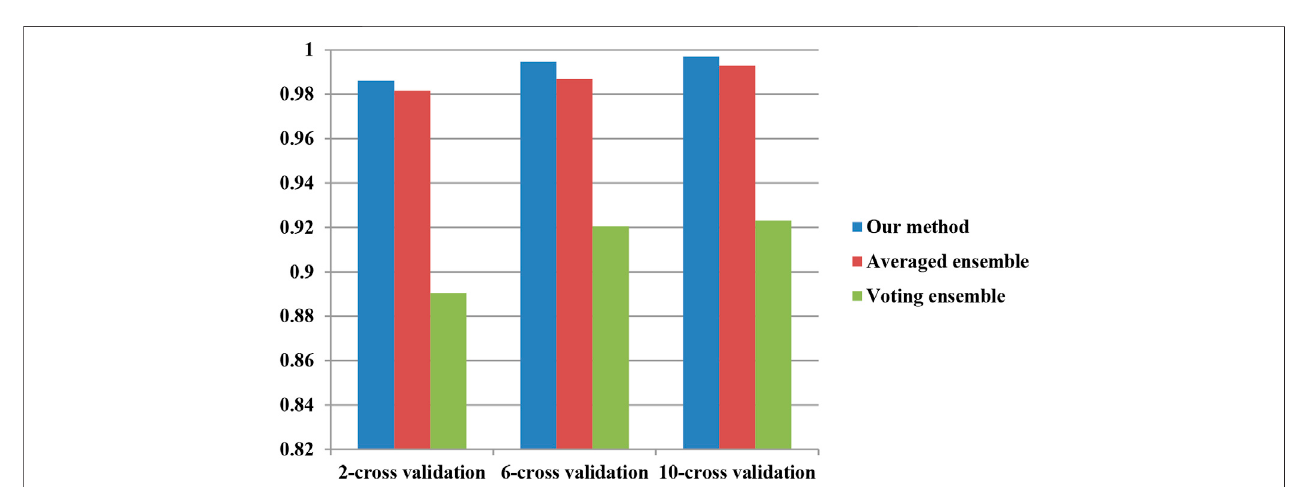
FIGURE 11 | AUC performances of hypertension-related compound by three ensemble